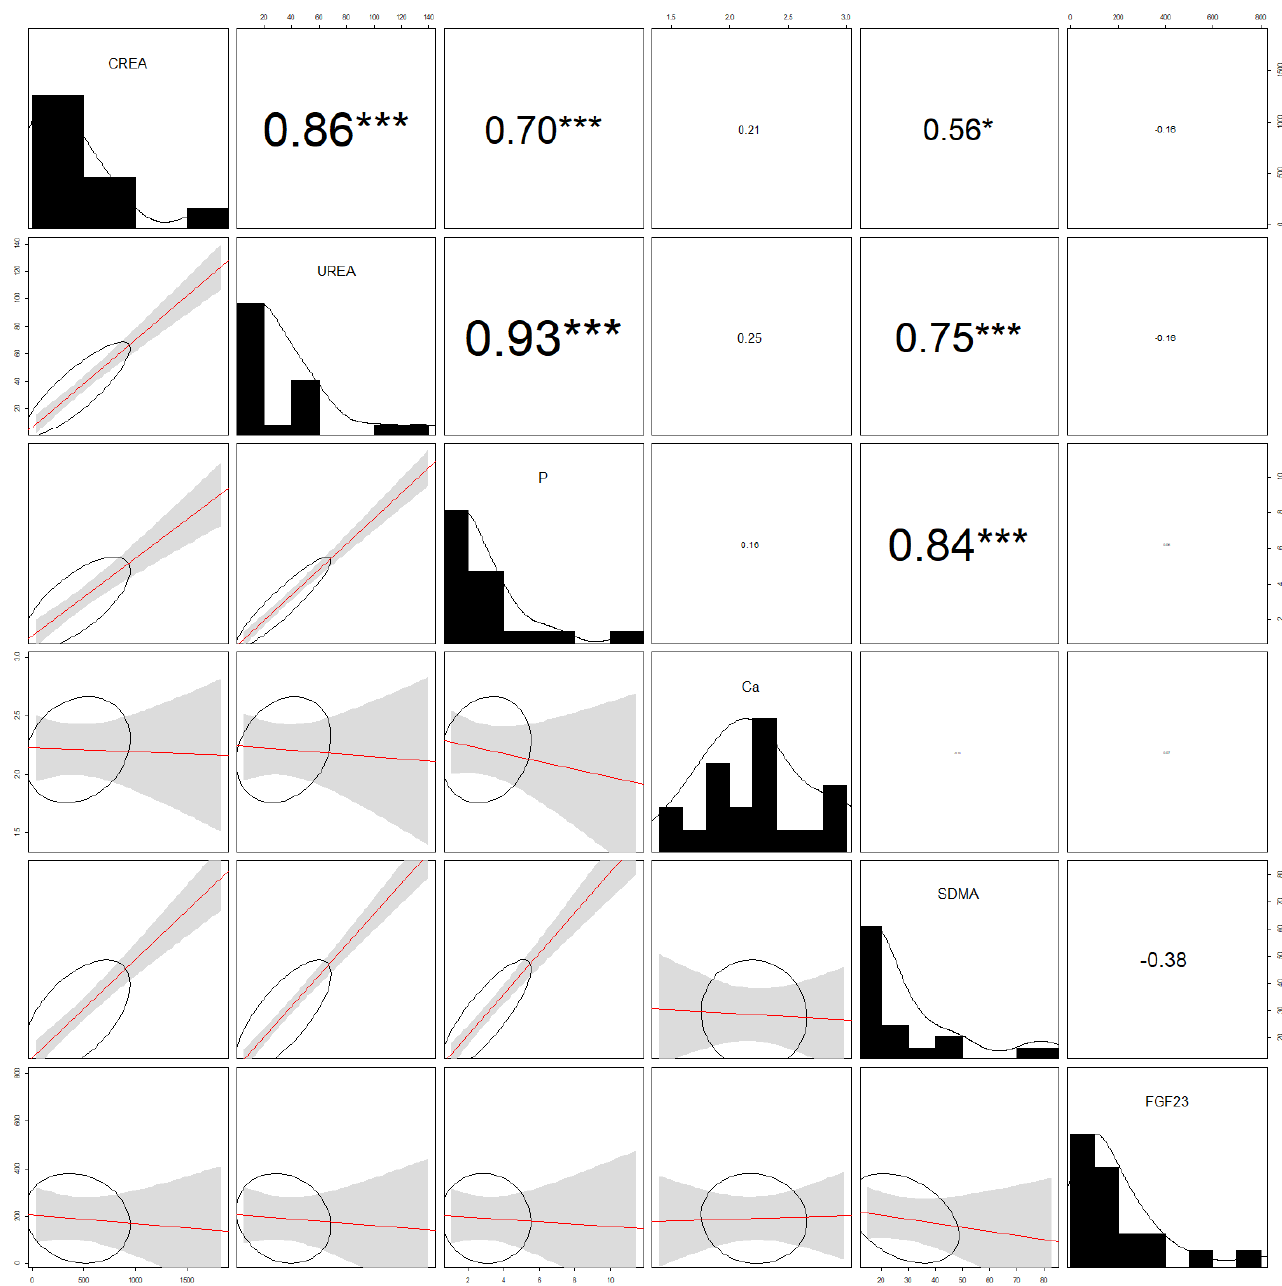
Figure 3. Analysis of correlations (correlograms) among levels of selected parameters in the CKD group of cats. CREA, creatinine; P, phosphate; Ca, calcium; SDMA, symmetric dimethylarginine; FGF 23, fibroblast growth factor 23. The coefficients of Pearson product-moment correlation are reported. Significance is given by * p < 0.05 and *** p < 0.001.